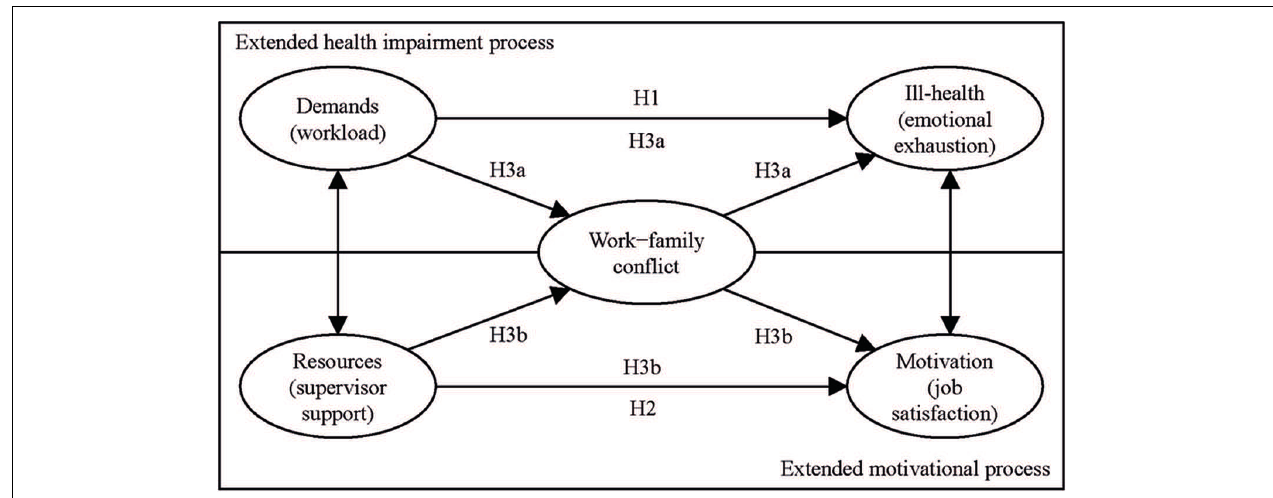
FIGURE 1 | Extended version of the JD–R model. H,